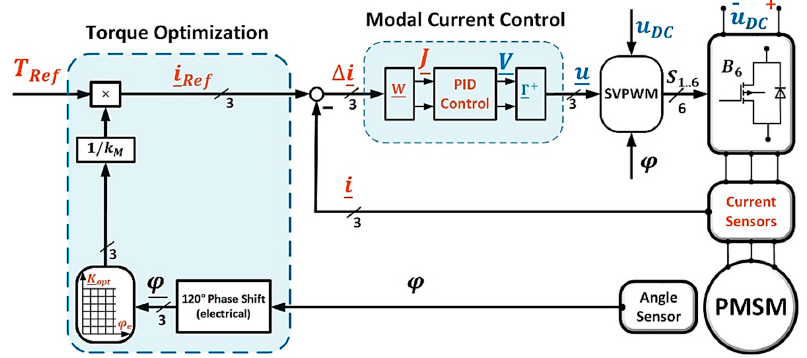
Figure 3. Proposed Combined Optimal Torque and Modal Current Control (OTMIC) diagram of PM motor drive system.